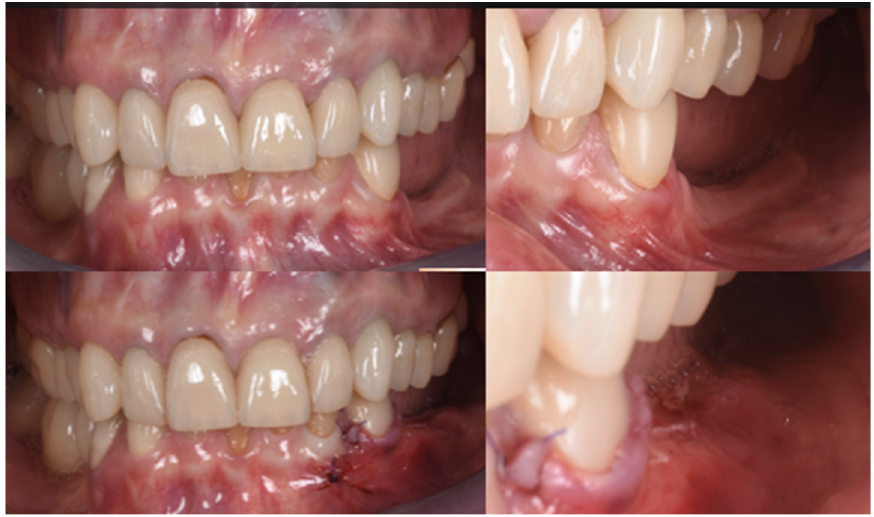
Figure 7. Comparison between the edentulous ridge before the surgery and immediately after the bone augmentation procedure.